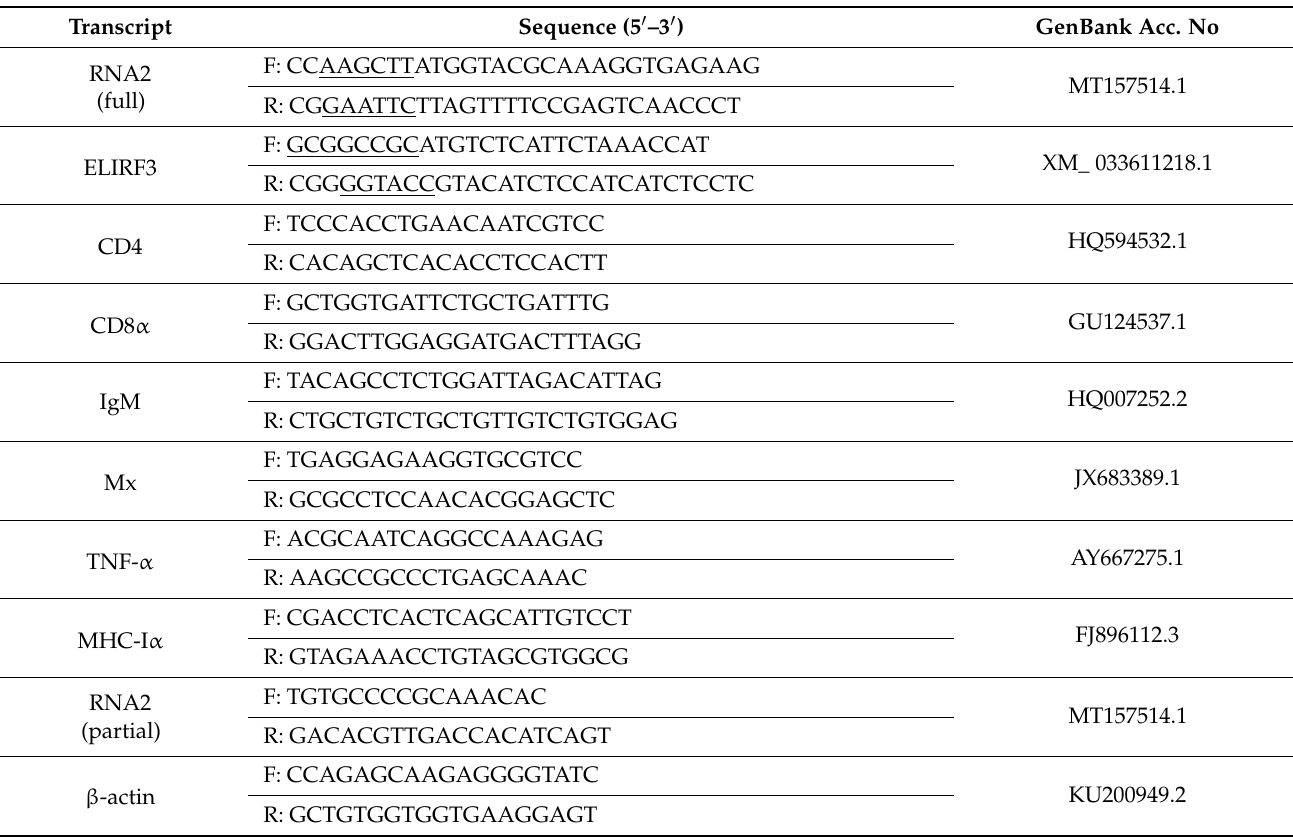
Table 1. The sequences of primers used in this